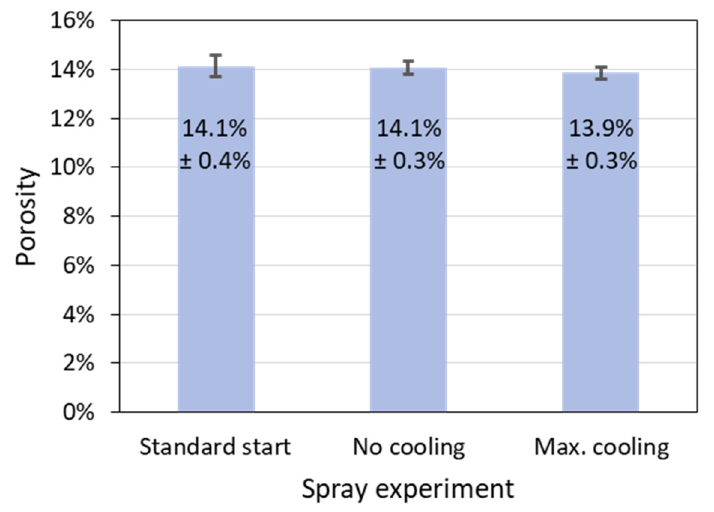
Figure 13. Porosities determined by image analysis of the two samples without and with maximum cooling as well as of the standard sample; the error bars denote the standard deviations of the porosities obtained from five images in each case.